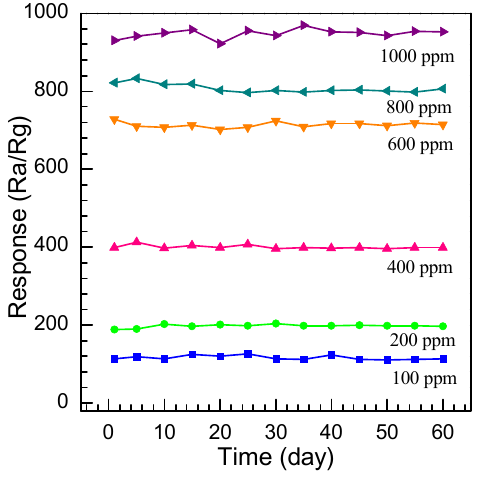
Figure 14. The stability of the SnO 2 nanosheet sensor.